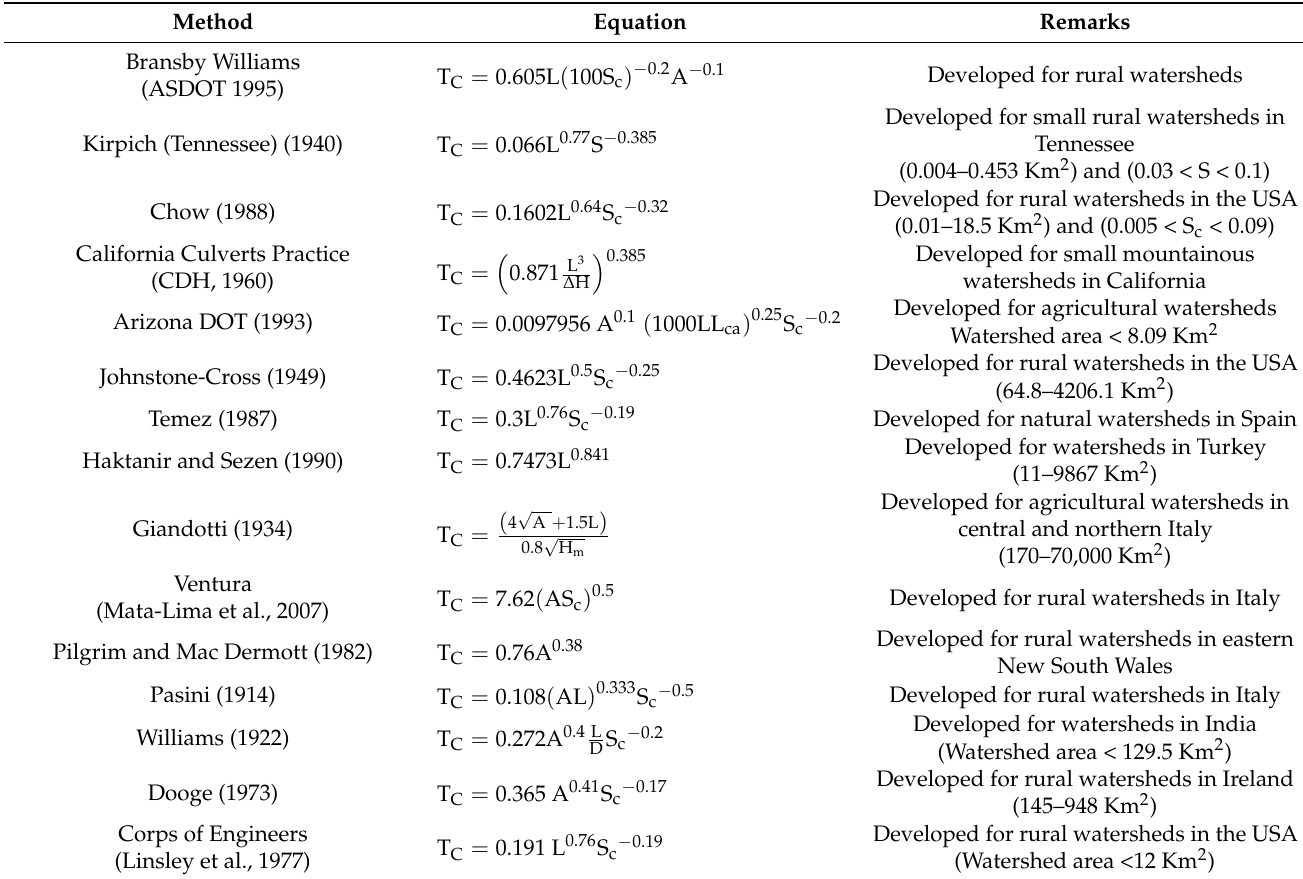
Table 3. Summary of the selected empirical methods for estimating